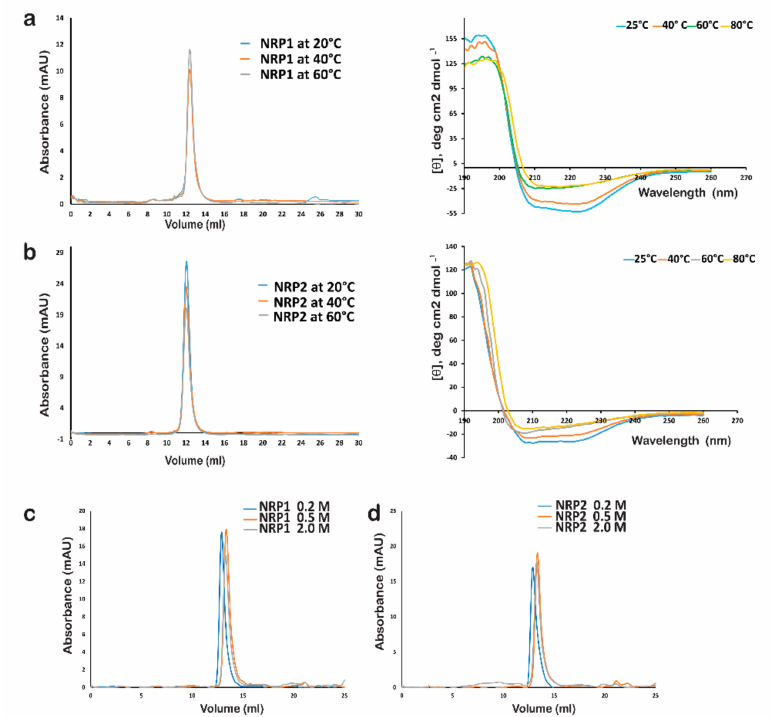
Figure 8. Analysis of AtNRP1 and AtNRP2 stability. Analytical gel-filtration chromatograms (left panel) and Far-UV CD curves (right panel) for the full-length forms of ( a ) AtNRP1, and ( b ) AtNRP2, showing the elution of the respective proteins at the same position, irrespective of heating at di ff erent temperatures and Far-UV CD curves for 25, 40, 60, and 80 ◦ C respectively, showing no major change in secondary structure at the respective temperatures. Analytical gel-filtration chromatogram for the full-length forms of ( c ) AtNRP1, and ( d ) AtNRP2 showing the elution of the respective proteins at the same position, irrespective of the salt concentrations. All the gel-filtration experiments were carried out in a bu ff er containing 20 mM Tris-HCl (pH 8.0), but with di ff erent concentrations of NaCl (0.2, 0.5, and 2.0 M) using a Superdex 200 10 / 300